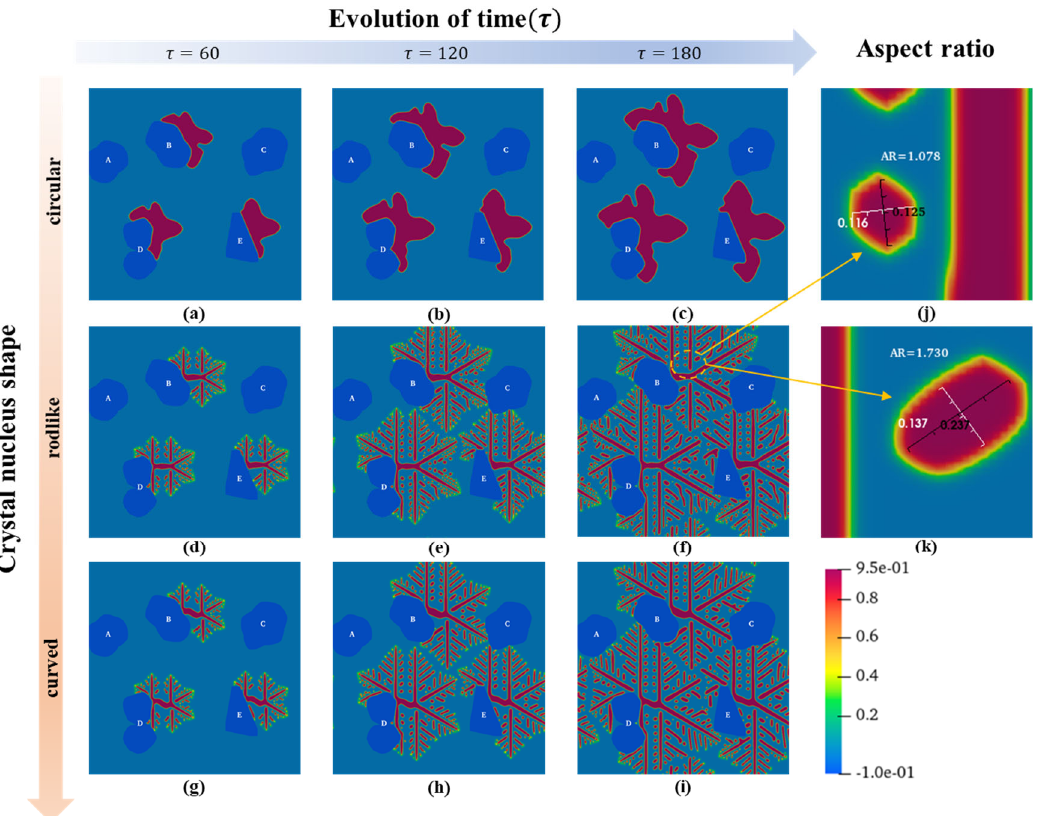
Figure 6. Morphology evolution diagram of a PTFE crystal with different nucleus shapes with a second-phase filler. ( a – c ) Circular crystal nucleus, ( d – f ) rodlike crystal nucleus, ( g – i ) curved crystal nucleus, ( j , k ) two examples of the defining aspect ratio (AR) for the effective branches.